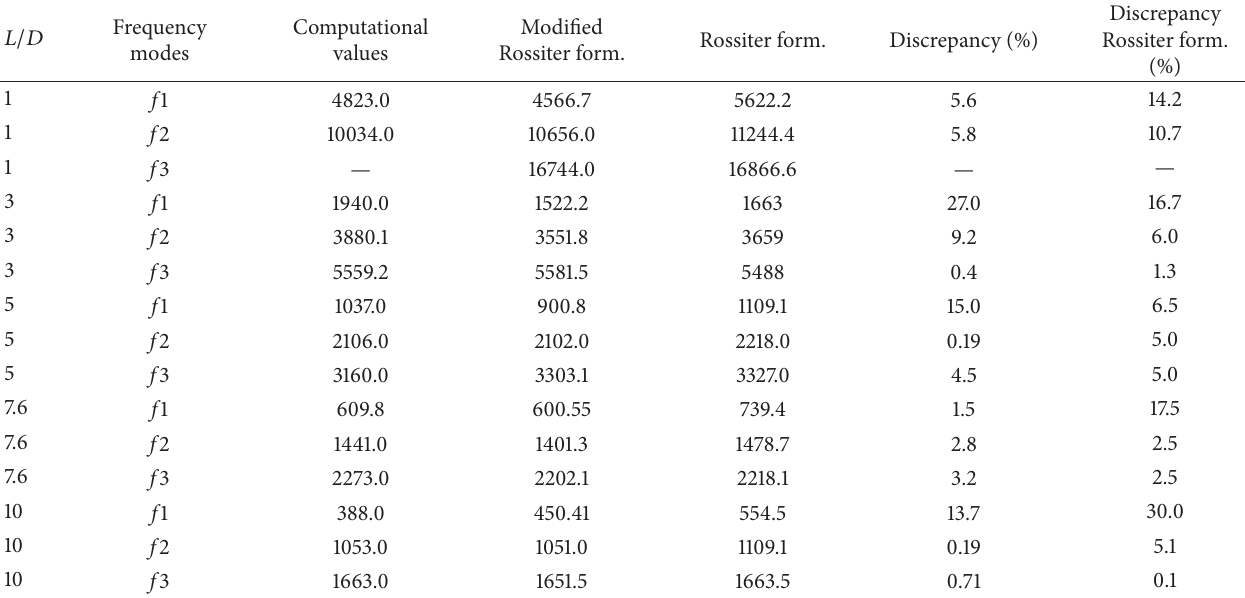
represent a clear open cavity flow mechanism using 𝑥 - velocity data for different times along one Rossiter